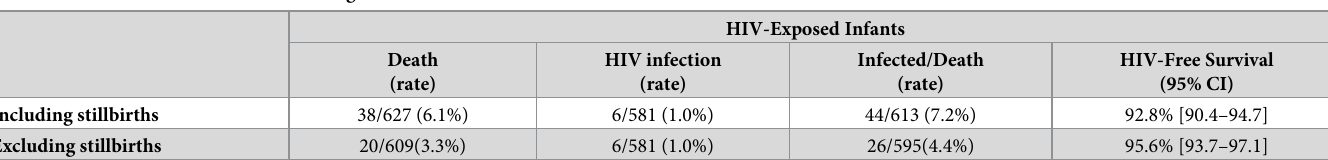
Table 4. HIV-free survival at six weeks of age.